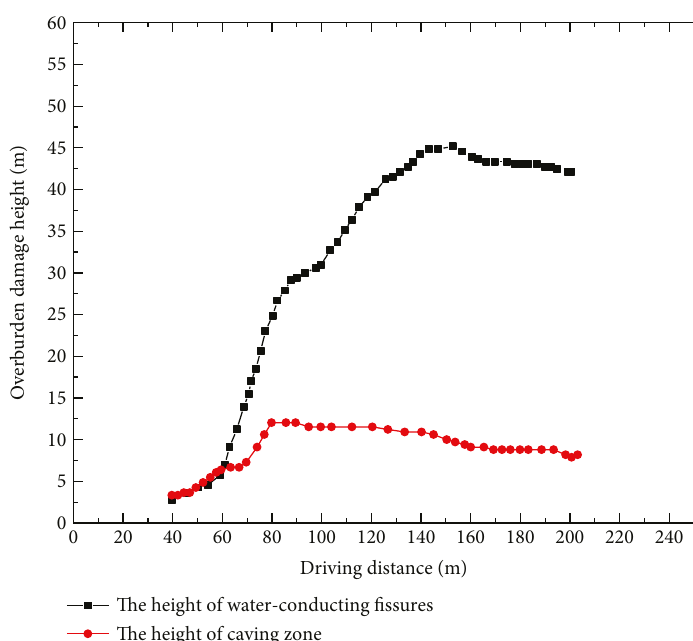
Figure 10: Relationship between overburden damage height and driving distance of the working face.